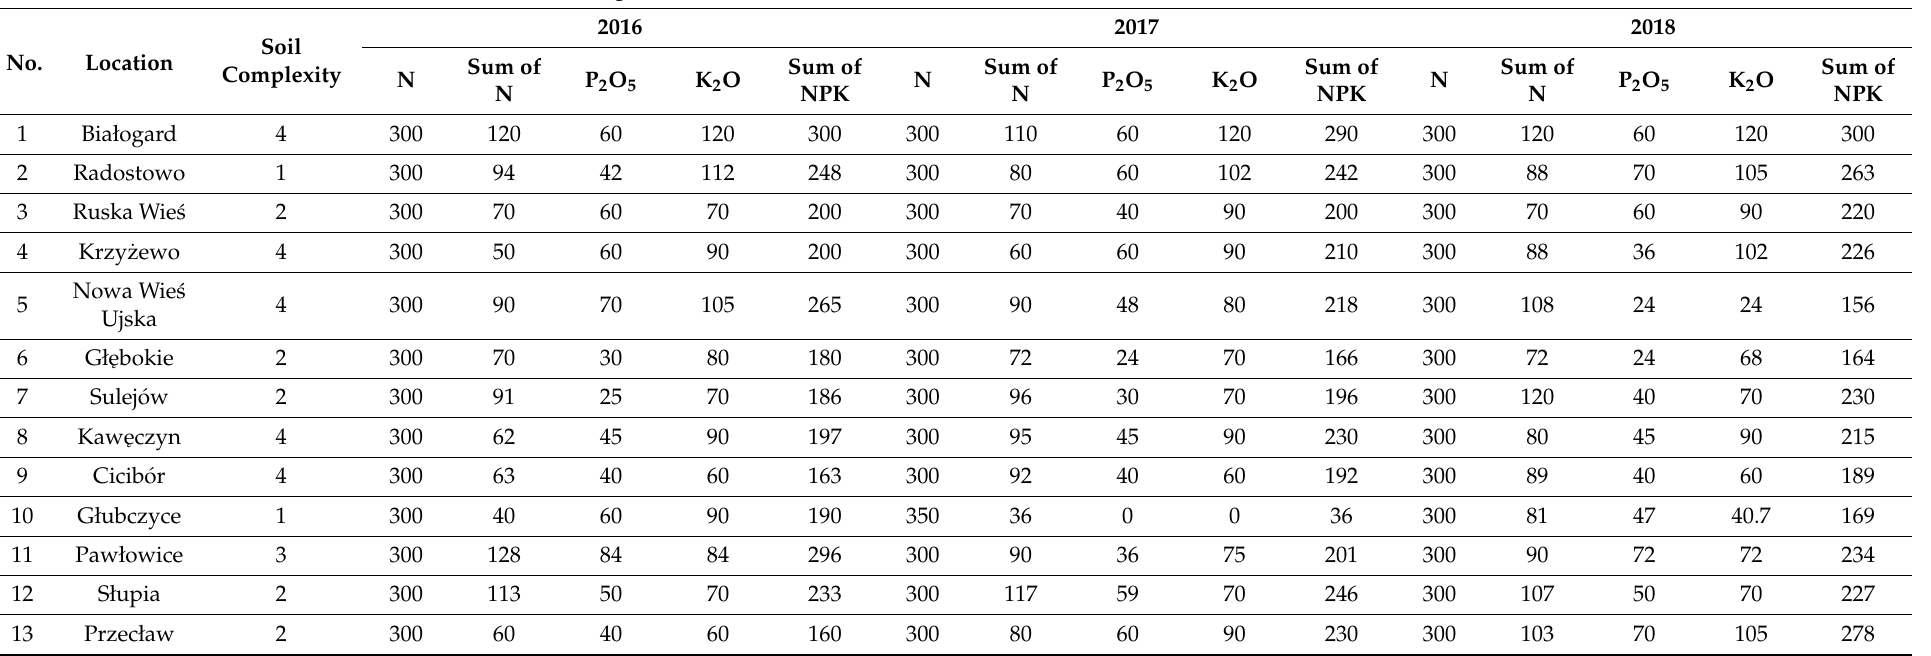
Table 2. Management of the trials across the thirteen environments and three years: mineral fertilization including nitrogen, phosphorus, and potassium adapted to the conditions in each location (soil